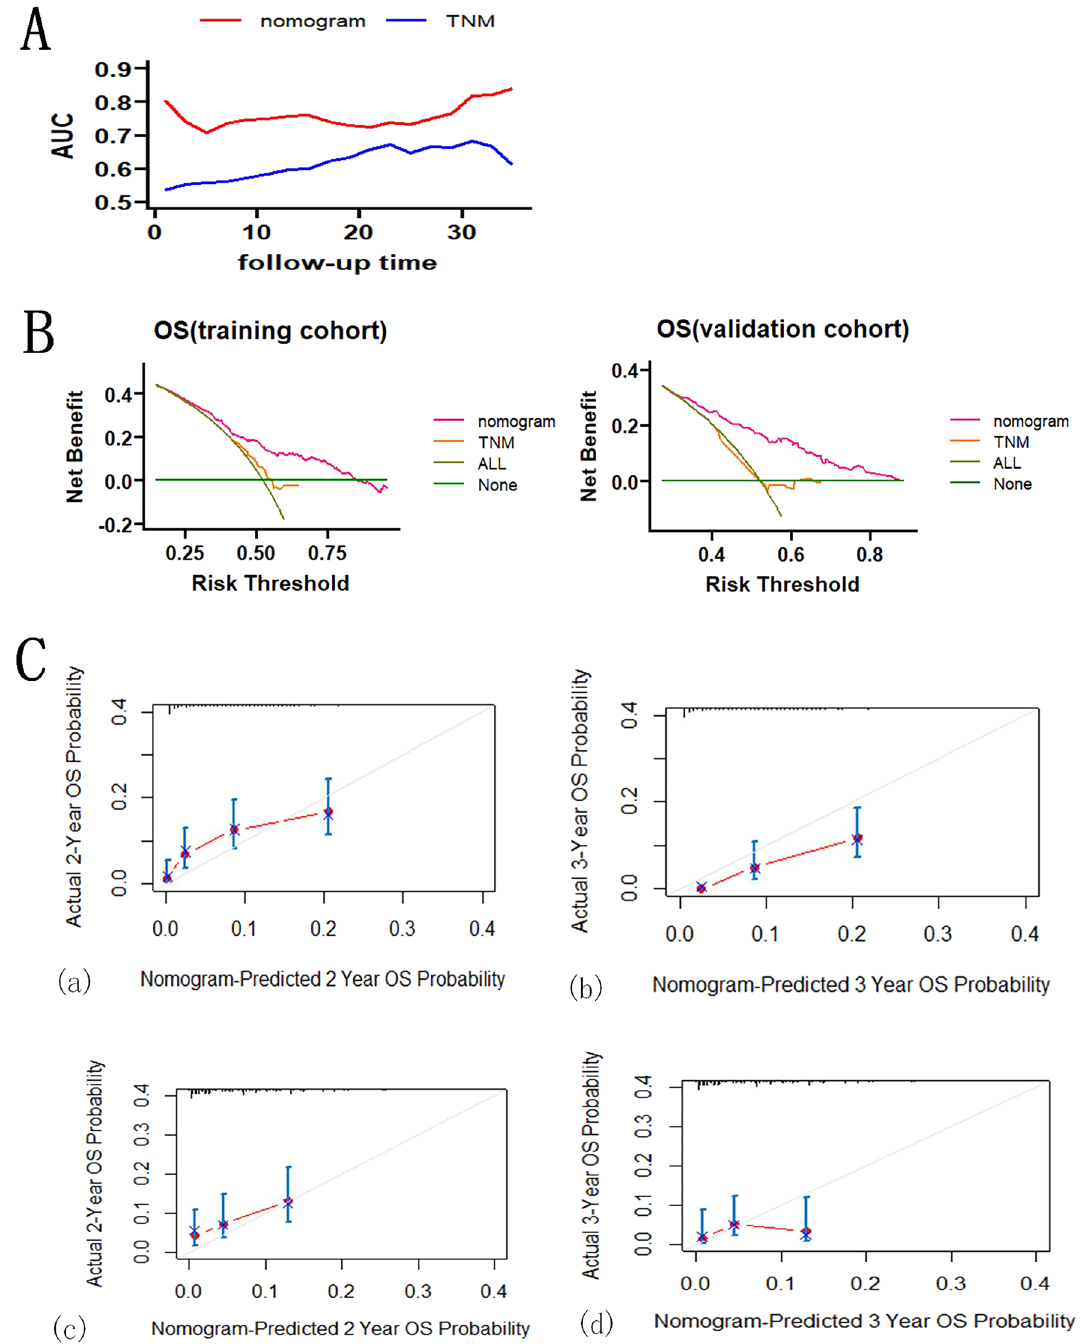
Figure 2. Efficacy of nomogram. ( A ) AUC curve over time for nomogram model and TNM stage. ( B ) Training set and validation set calibration model. ( C ) The DCA of the training set versus the validation